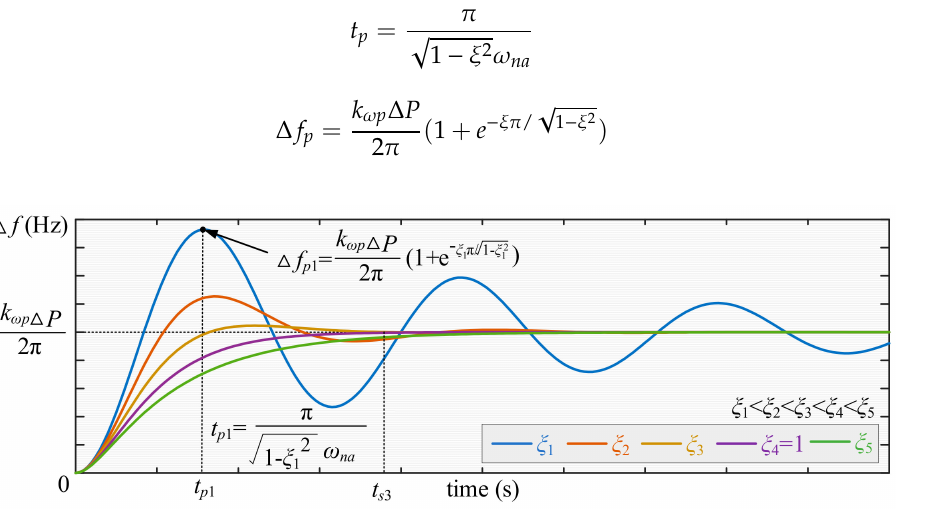
Figure 7. Frequency fluctuation under di ff erent values of ξ